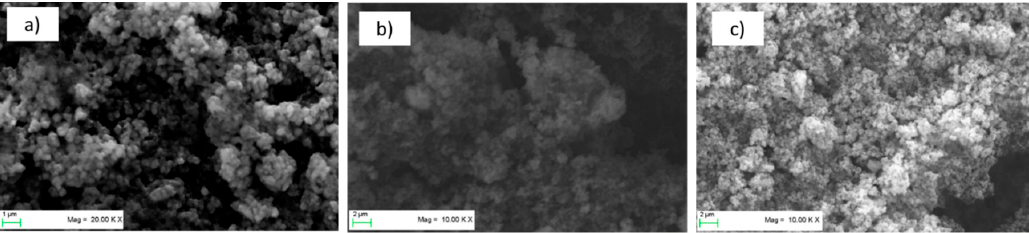
Figure 3. SEM images of the three types of pristine electrodes: ( a ) Li 4 Ti 5 O 12 (LTO)-sodium alginate (SA), ( b ) LTO-PVDF-carboxymethyl cellulose (CMC) and ( c ) LTO-PVDF-SA.